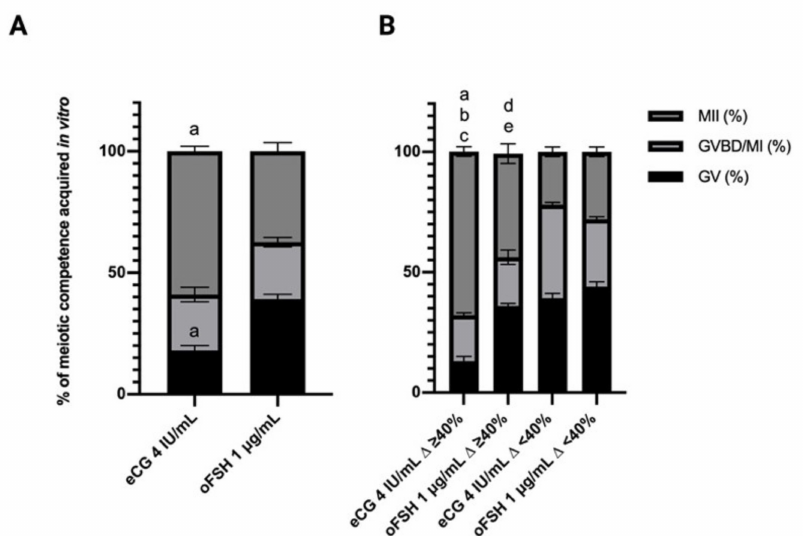
Figure 3. Percentage of oocyte meiotic competence acquired in vitro: an overview of germ cells’ nuclear stages. ( A ) All the oocytes recovered by follicular gonadotropin treatments independently of their ∆ growth%. ( B ) % of oocyte recovered from follicle with ∆ growth ≥ or < 40%. Letters indicate significant differences a eCG 4 IU ∆ ≥ 40% vs. FSH 1 µ g/mL ∆ ≥ 40%; b eCG 4 IU ∆ ≥ 40% vs. eCG 4 IU ∆ < 40%; c eCG 4 IU ∆ ≥ 40% vs. FSH 1 µ g/mL ∆ < 40%; d FSH 1 µ g/mL ∆ ≥ 40% vs. eCG 4 IU ∆ < 40%; e FSH 1 µ g/mL ∆ ≥ 40% vs. FSH 1 µ g/mL ∆ < 40%. MII: Metaphase II; GVBD/MI: Germinal Vesicle Break Down/Metaphase I; GV: Germinal Vesicle. Three independent biological replicates were performed with 66, 67, and 67 follicles per group (eCG 4 IU/mL and oFSH 1 µ g/mL). For each iv F group (oFSH 1 µ g/mL and eCG 4 IU/mL) 116 and 122 follicles, respectively, were analyzed at the end of the in vitro culture for both follicular and oocyte performance. Only those follicles that differentiated the follicular antrum, identified on the stereomicroscope as a transparent cavity filled with follicular fluid, were tested. For each iv F group (oFSH 1 µ g/mL and eCG 4 IU/mL), 116 and 122 healthy oocytes were recovered and analyzed at the end of the in vitro culture to test the oocyte performance. Only the oocytes retrieved from follicles that differentiated the follicular antrum, identified on the stereomicroscope as a transparent cavity filled with follicular fluid, were